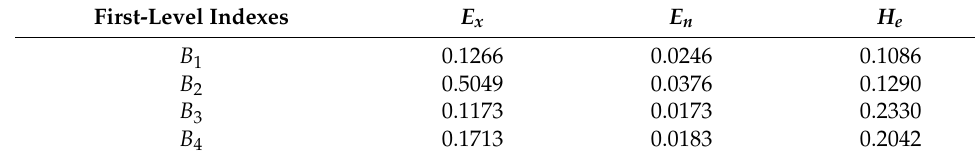
Table 11. Comprehensive digital features of four indexes in criterion level.